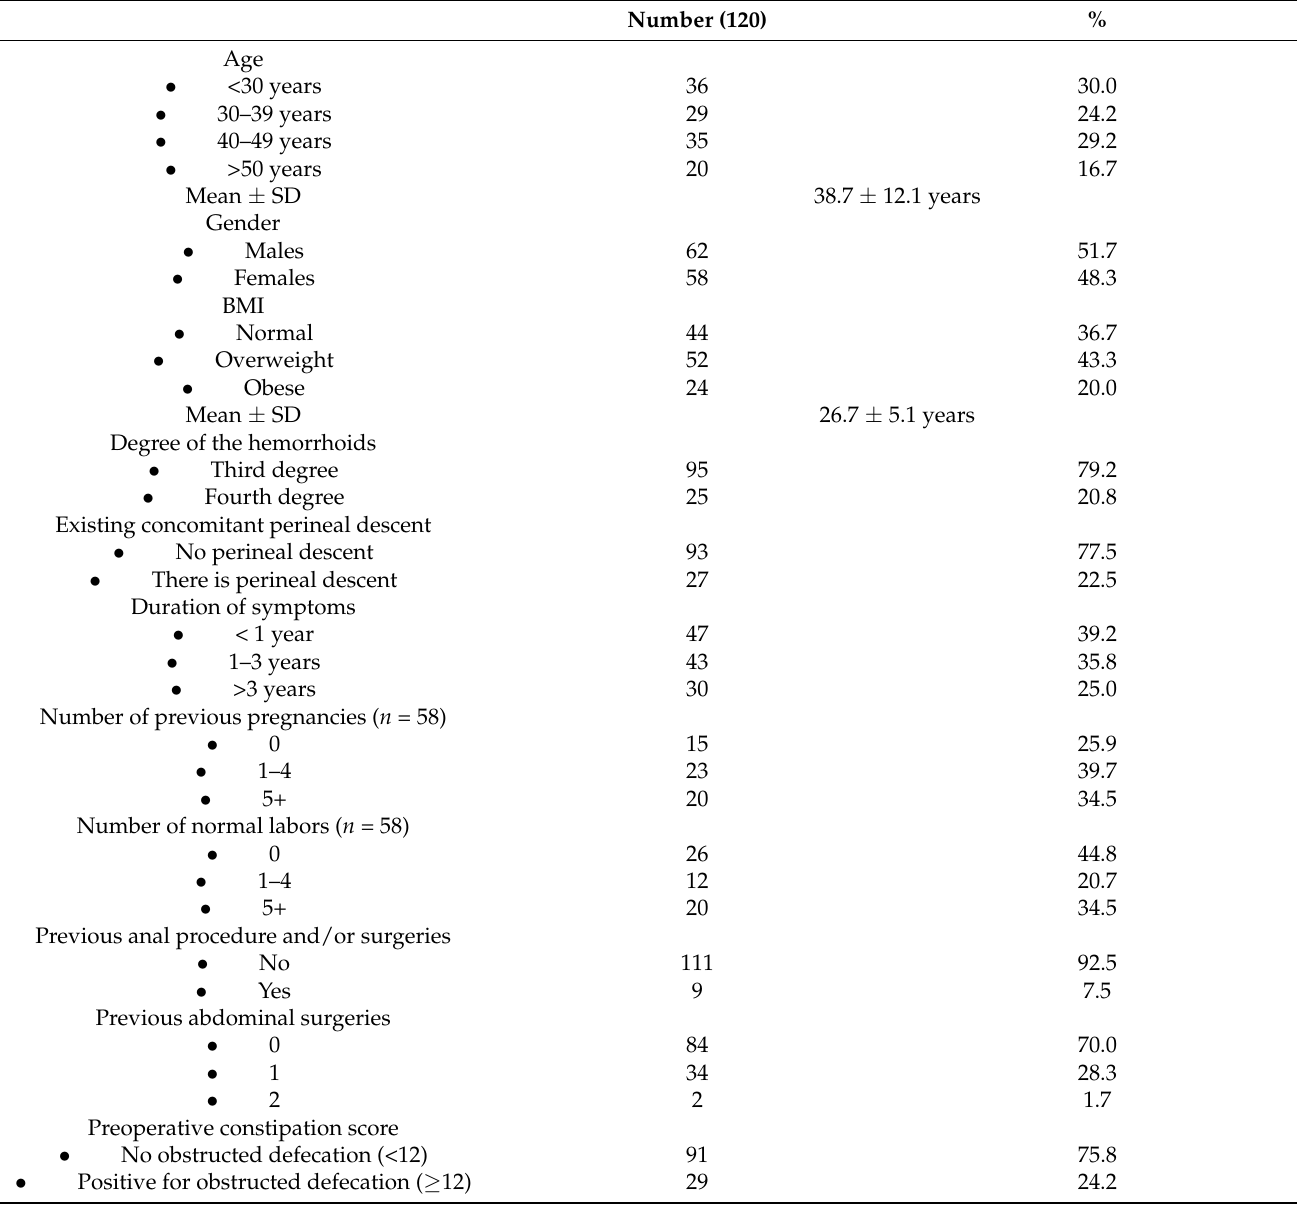
Table 1. Demographic and clinical data of the studied group (N =